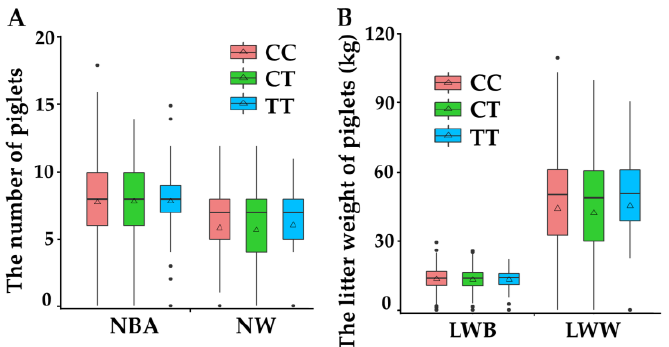
Figure 2. Descriptive statistics for phenotypes of Duroc pigs with three genotypes. ( A ) The descriptive statistics for genotypes of NBA and NW of the three phenotypes of Duroc pigs; ( B ) The descriptive statistics for genotypes of LWB and LWW of the three phenotypes of Duroc pigs. Notes: NBA— number of piglets born alive, LWB—litter weight at birth, LWW—litter weight at weaning, NW— number of piglets